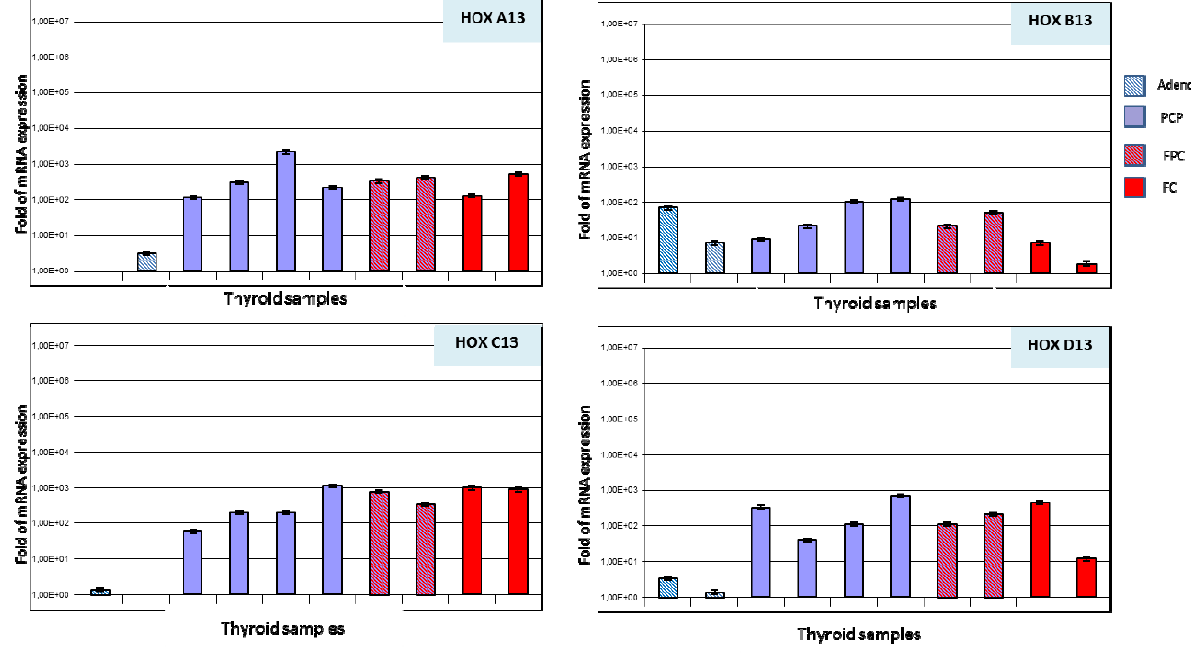
Figure 3. Real Time PCR expression of HOX A13 , HOX B13 , HOX C13 and HOX D13 genes in thyroid tissue samples. All reactions were performed in triplicate and data are expressed as mean of relative amount of mRNAs levels.